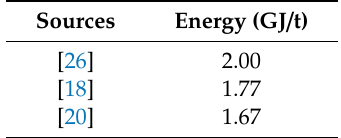
Table 4. Cast ingot energy per ton of aluminum.